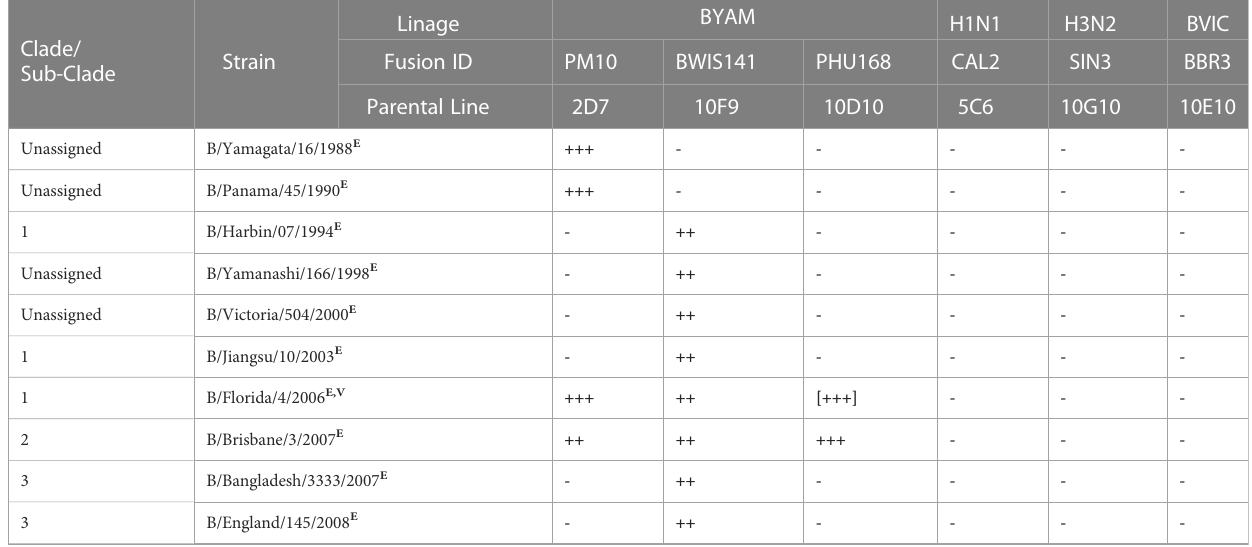
TABLE 4 Cross reactivity of monoclonal antibody (mAb) panel speci fi c to in fl uenza B Yamagata lineage screened against egg derived (E) and cell derived (C) vaccine antigen.